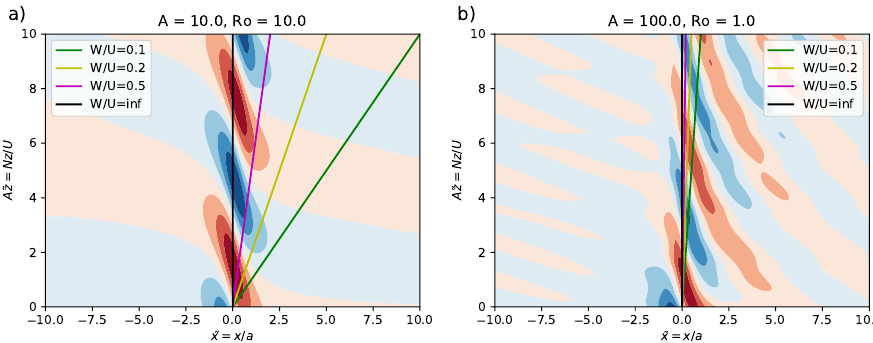
Figure 4. Vertical velocity for the mountain wave solution for the ( a ) A = 10.0, Ro = 10.0 and ( b ) A = 100.0, Ro = 1.0 cases. Plotted on top are the virtual radiosonde trajectories for non-dimensional ascent rates, W / U = 0.1,0.2,0.5 and ∞ (a vertical profile).